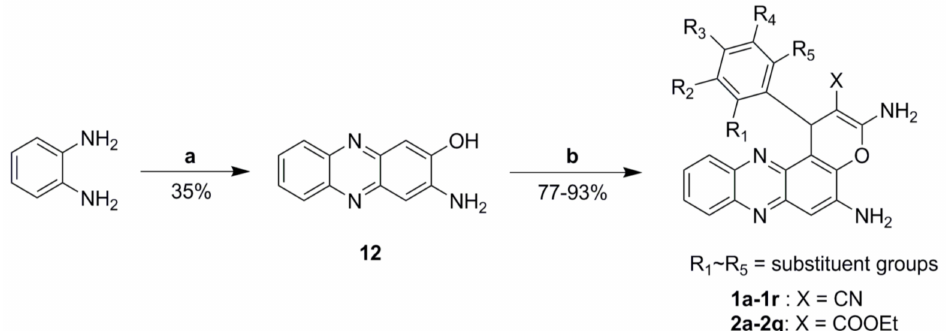
Figure 5. The structure of pyrano[3,2-a]phenazine derivatives. ( 1c : R 1 , R 2 , R 4 , R 5 = H, R 3 = Cl. 1i : R 1 , R 4 , R 5 = H, R 2 , R 3 = Cl. 2e : R 1 = Br, R 2 , R 3 , R 4 , R 5 =H. 2l : R 1 , R 2 = Cl, R 3 , R 4 , R 5 =